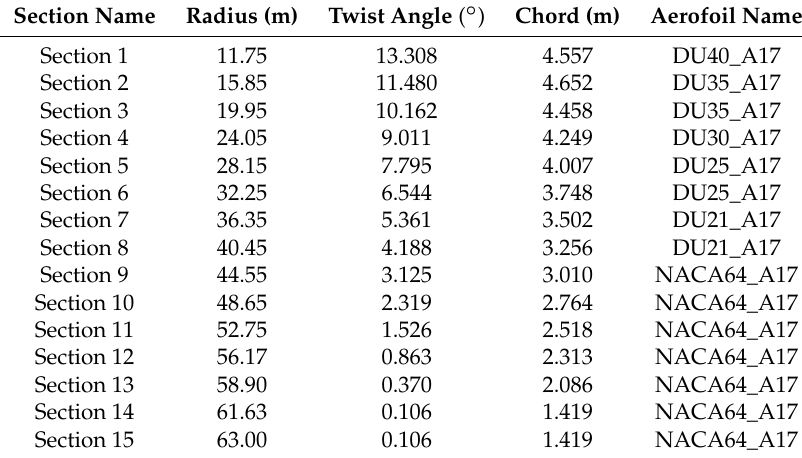
Table A1. Aerofoil details of the